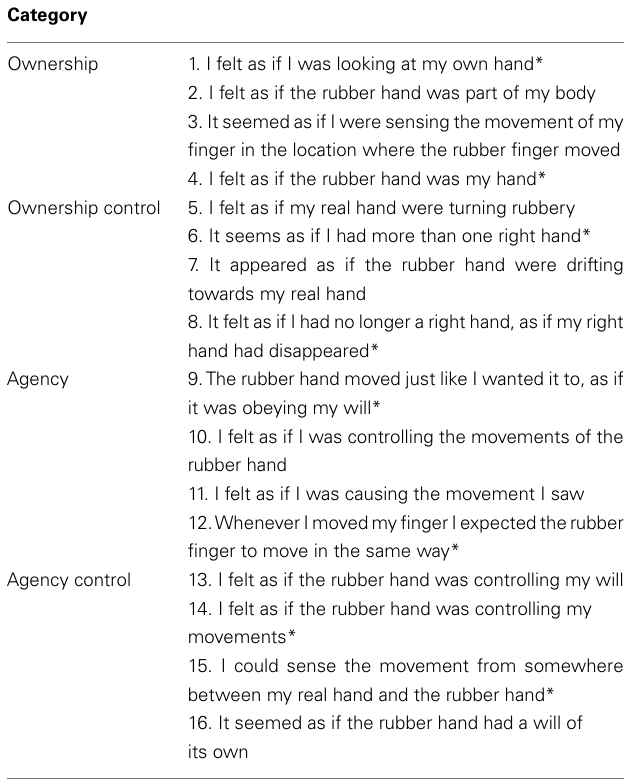
Table 1 |The questionnaire, consisting of 16 statements divided into four different